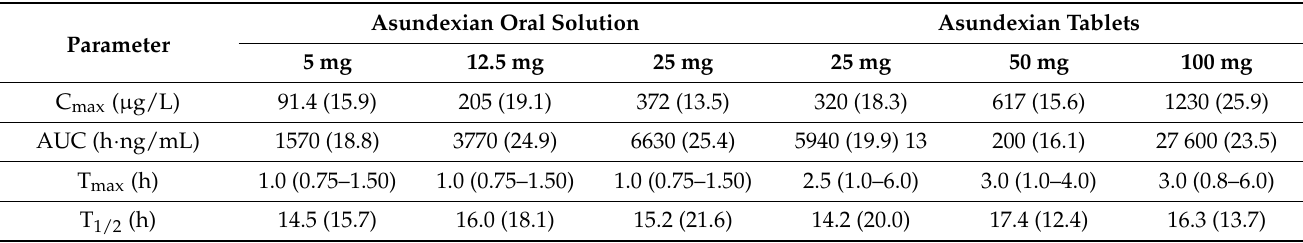
Table 7. Plasma pharmacokinetic parameters of asundexian. Geometric Mean (Geometric Mean CV%) asundexian PK parameters. For T max , data are presented as median (min-max). Data are from Thomas, D et al. [29]. C max : Maximum plasma concentration; T max : time to reach C max . AUC: area